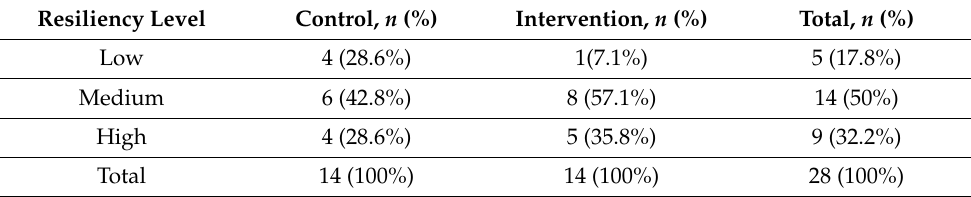
Table 3. Participant resiliency level during the COVID-19 pandemic. Resiliency